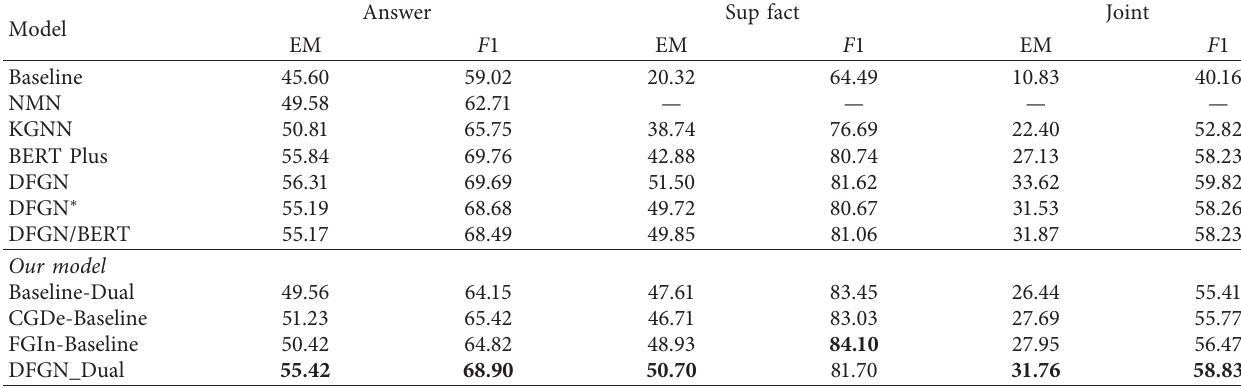
Table 1: The performance of our model and competing approaches on the HotpotQA dataset.